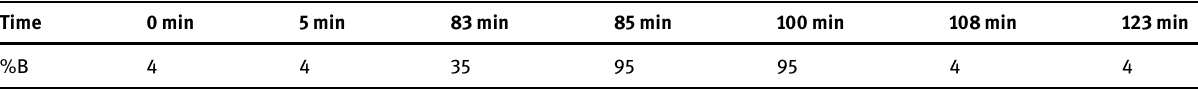
Table 2: Gradient pro fi le used for the peptide C18 separation